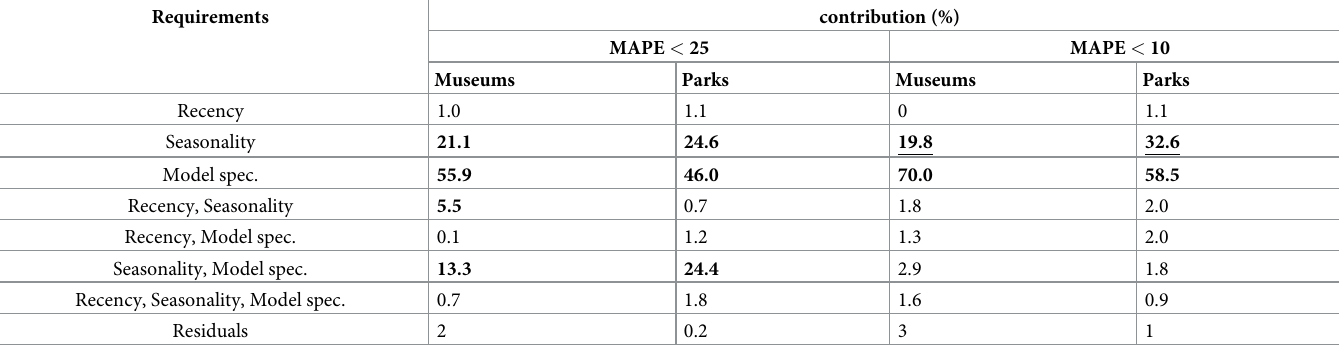
Table 8. Contribution of each of tourism prediction requirements: Recency, seasonality, model specialization and their interactions into the response variable in each category of attractions: Parks and museums; results for MAPE < 10 and MAPE < 25 in 5 runs. The contributions higher than 5% are in bold face. The analysis of the statistical significance of our numerical results are presented in details in the Appendix B in Tables 16 and 17.